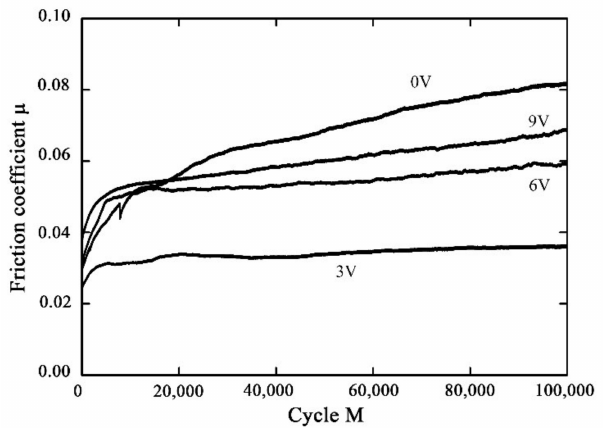
Figure 20. The effect of the voltage on the friction coefficient curve of PVDF thin films with F n = 50 N, D = ±20 μm and ƒ = 15 Hz.